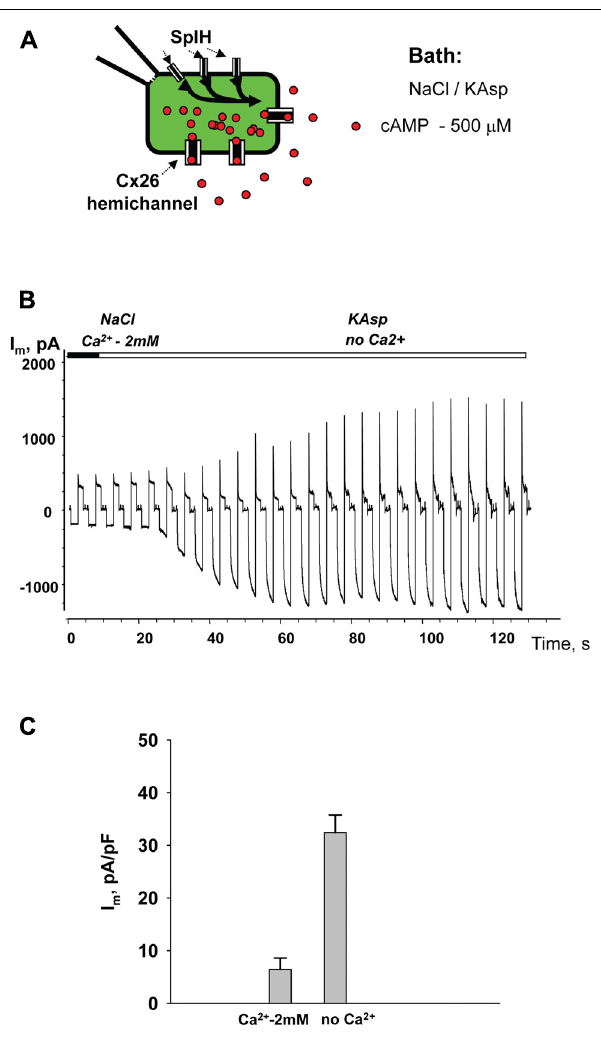
FIGURE 7 | cAMP uptake via Cx26 hemichannels. (A) Schematic of the experimental environment for HeLaCx26/SpIH cells. (B) Current recorded from a HeLa Cx26/SpIH-expressing cell. Perfusion with the Ca 2 + -free KAsp external solution induced a significant SpIH current increase over time. (C) Average of current densities measured from 5 cells: 6.4 ± 2.2 versus 32.3 ± 3.3 pA/pF, before and after perfusion, respectively; P = 0.008. 500 μ M of cAMP was present in the external solution throughout the entirety of the experiment.